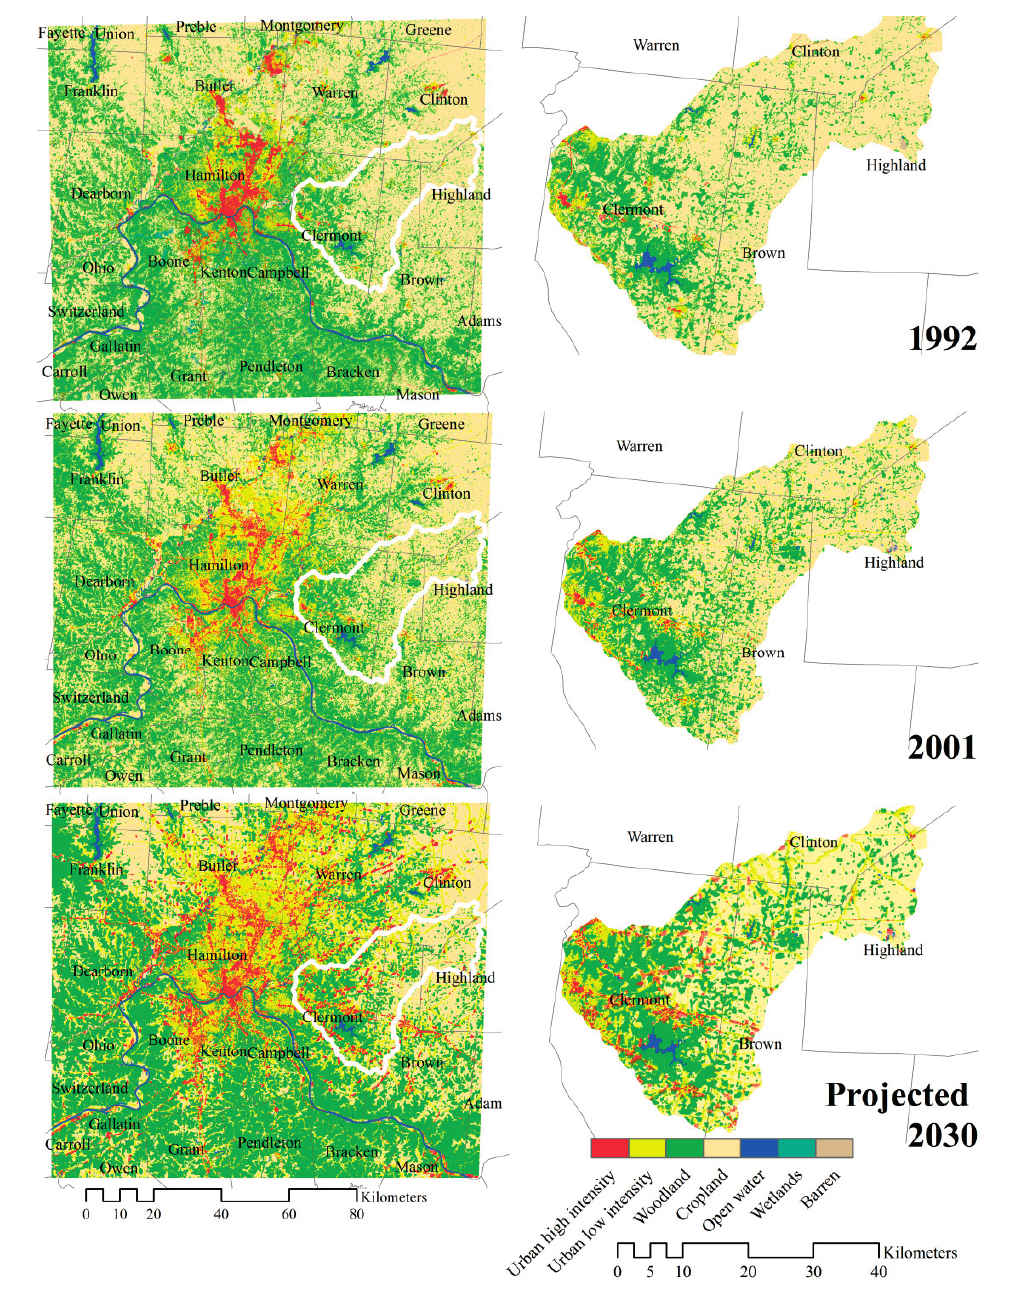
Figure 3. The 1992–2001 land cover change derived from NLCD and the 2030 land cover